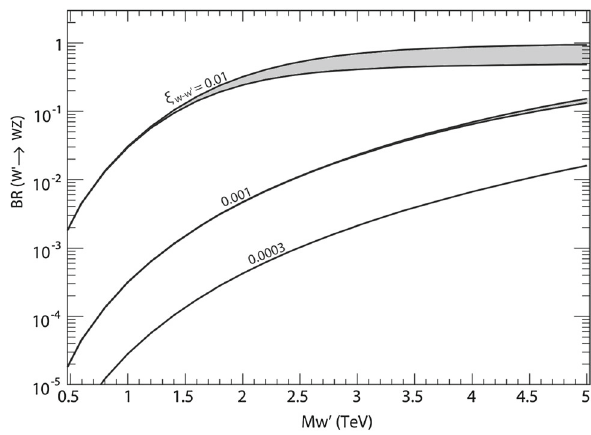
Fig. 1 BranchingfractionBR ( W (cid:2) → W Z ) (solid)vs M W (cid:2) intheEGM for W – W (cid:2) mixing factor ξ W − W (cid:2) = 3 · 10 − 4 , 10 − 3 and 10 − 2 . The shaded bands represent the uncertainty resulting from the inclusion of the W H decay mode, the upper and lower bounds correspond to the assumptions (cid:11) WH = 0 and (cid:11) WH = (cid:11) WZ , respectively W (cid:2) W (cid:2) W (cid:2)